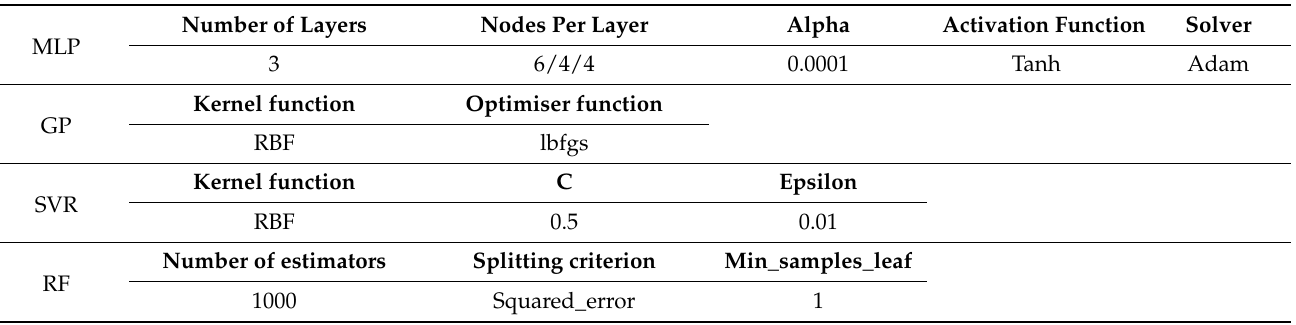
Table 2. Hyperparameter values set for the ML algorithms MLP, GP, SVR and